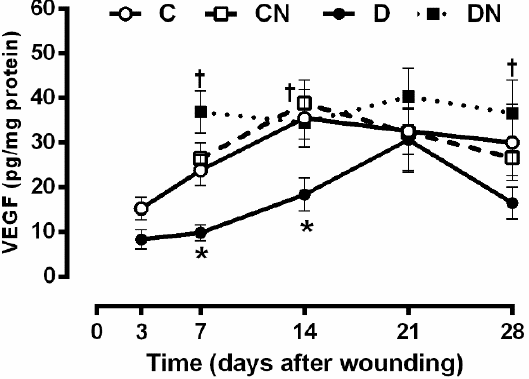
Figure 5. Effect of the topical acidified nitrite application on the wound tissue protein levels of the vascular endothelial growth factor (VEGF) ( n = 6/subgroup). C, untreated control; CN, acidified nitrite-treated control; D, untreated diabetes; and DN, acidified nitrite-treated diabetes. * p < 0.05 compared to untreated control rats, and † p < 0.05 compared to untreated diabetic rats. Values are the mean ± SEM.